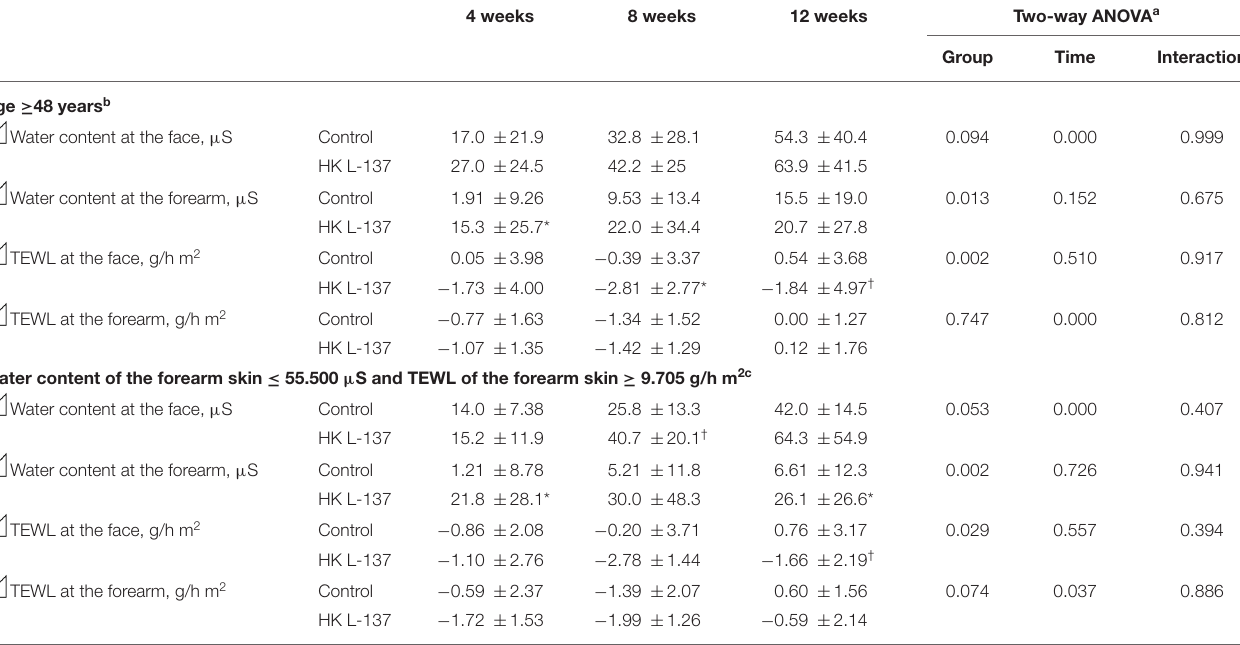
TABLE 4 | Analysis of water content of the stratum corneum and transepidermal water loss of the skin stratified by baseline age and skin